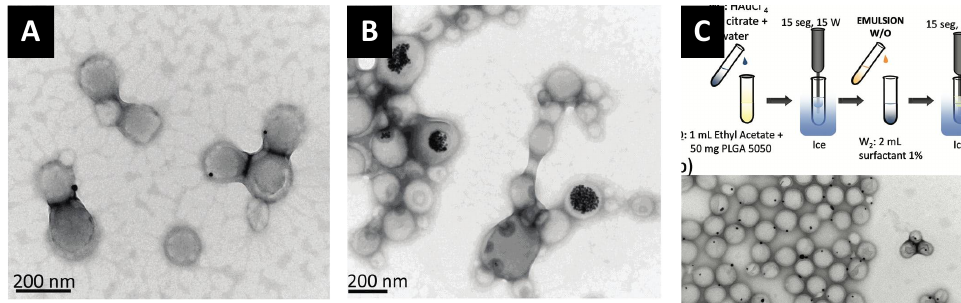
Figure 7. TEM images of poly(lactic-co-glycolic acid) (PLGA) nanoparticles encapsulating GNP prepared using various encapsulation methods. ( A ) Direct encapsulation of citrate-capped GNP in w / o / w emulsion (GNP are in the internal aqueous phase of the double emulsion). ( B ) Direct encapsulation of dodecanethiol-capped GNP in o / w emulsion (GNP are in the organic phase of the emulsion). ( C ) In situ reduction method in w / o / w emulsion (gold salt and reducing agent are in the internal aqueous phase of the double emulsion). Note that the different encapsulation routes resulted in different encapsulation outcomes; and the 1:1 encapsulation with minimal empty PLGA nanoparticles was obtained only when the in-situ reduction method was employed. Reproduced from Luque-Michel et al. [61] which is licensed under a Creative Commons Attribution CC BY 4.0 Internalional